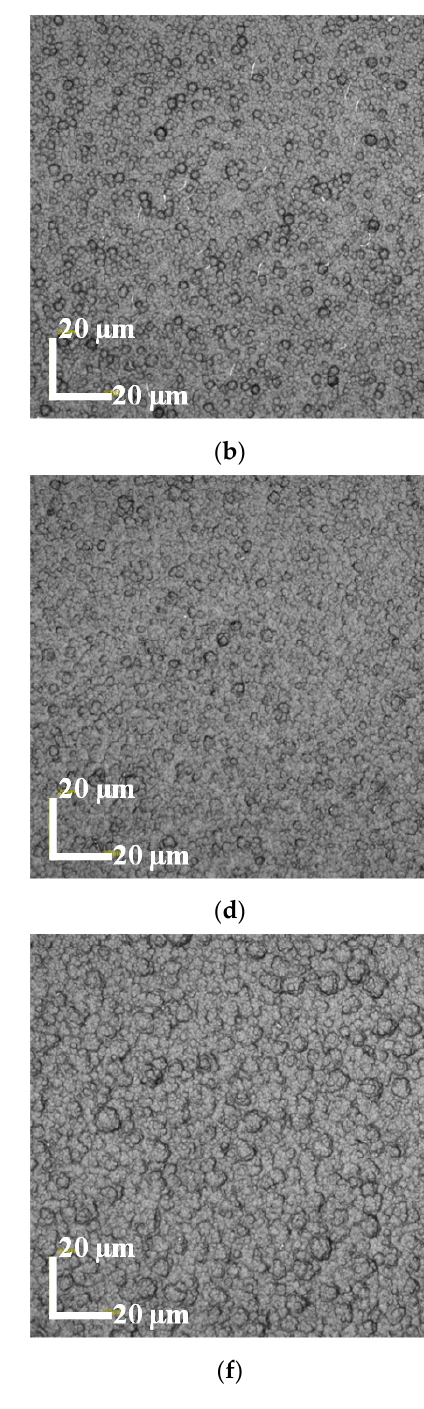
Figure 2. LSCM micrographs of the PPy(NO 3 − )-ISMs for polymerization durations 600 ( a ), 1200 ( b ), 1800 ( c ), 2400 ( d ), 3000 ( e ), and 3600 s ( f ).